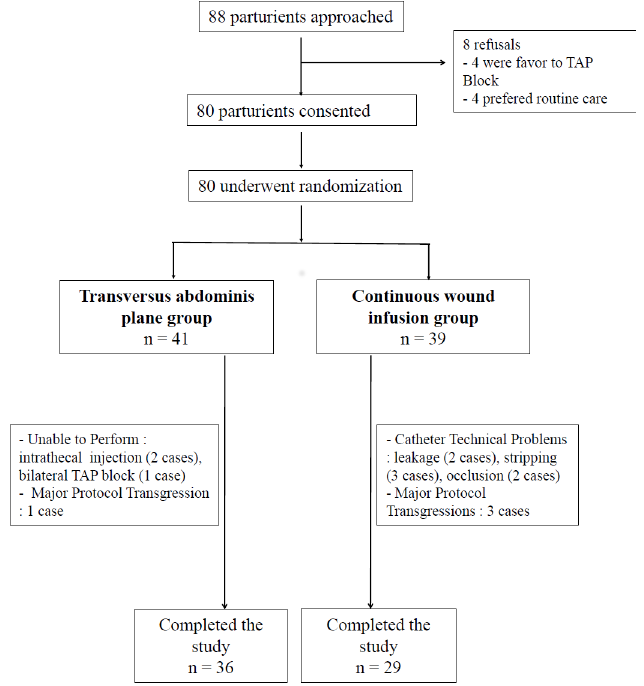
Figure 1. Consort trial diagram.